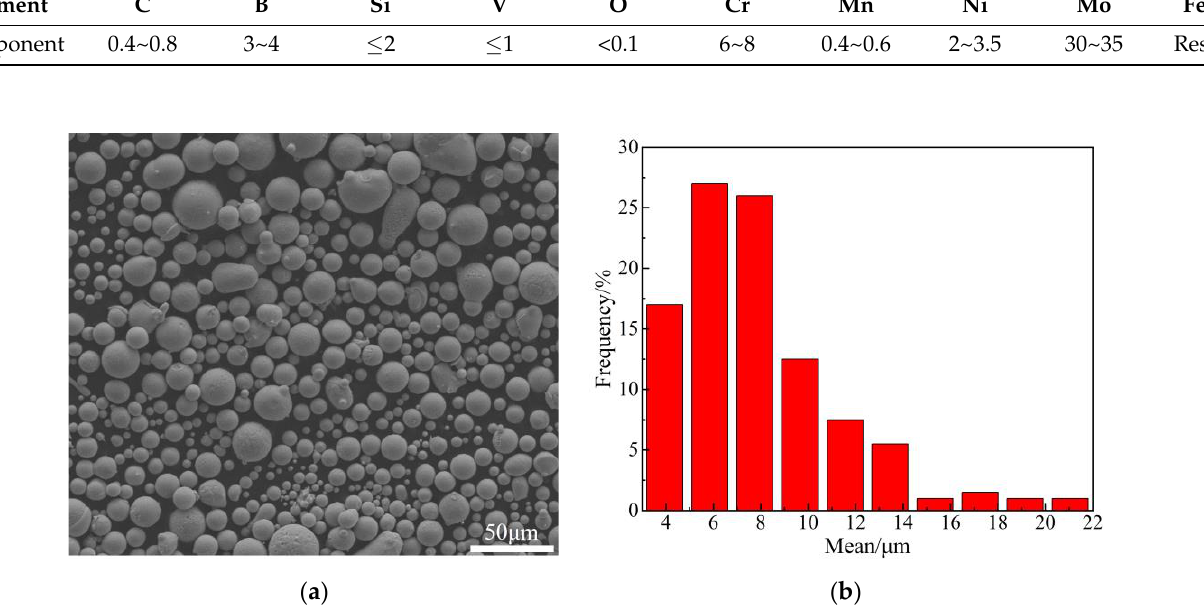
Figure 1. ( a ) The SEM morphology of Mo 2 FeB 2 powder; ( b ) size distribution of Mo 2 FeB 2 .